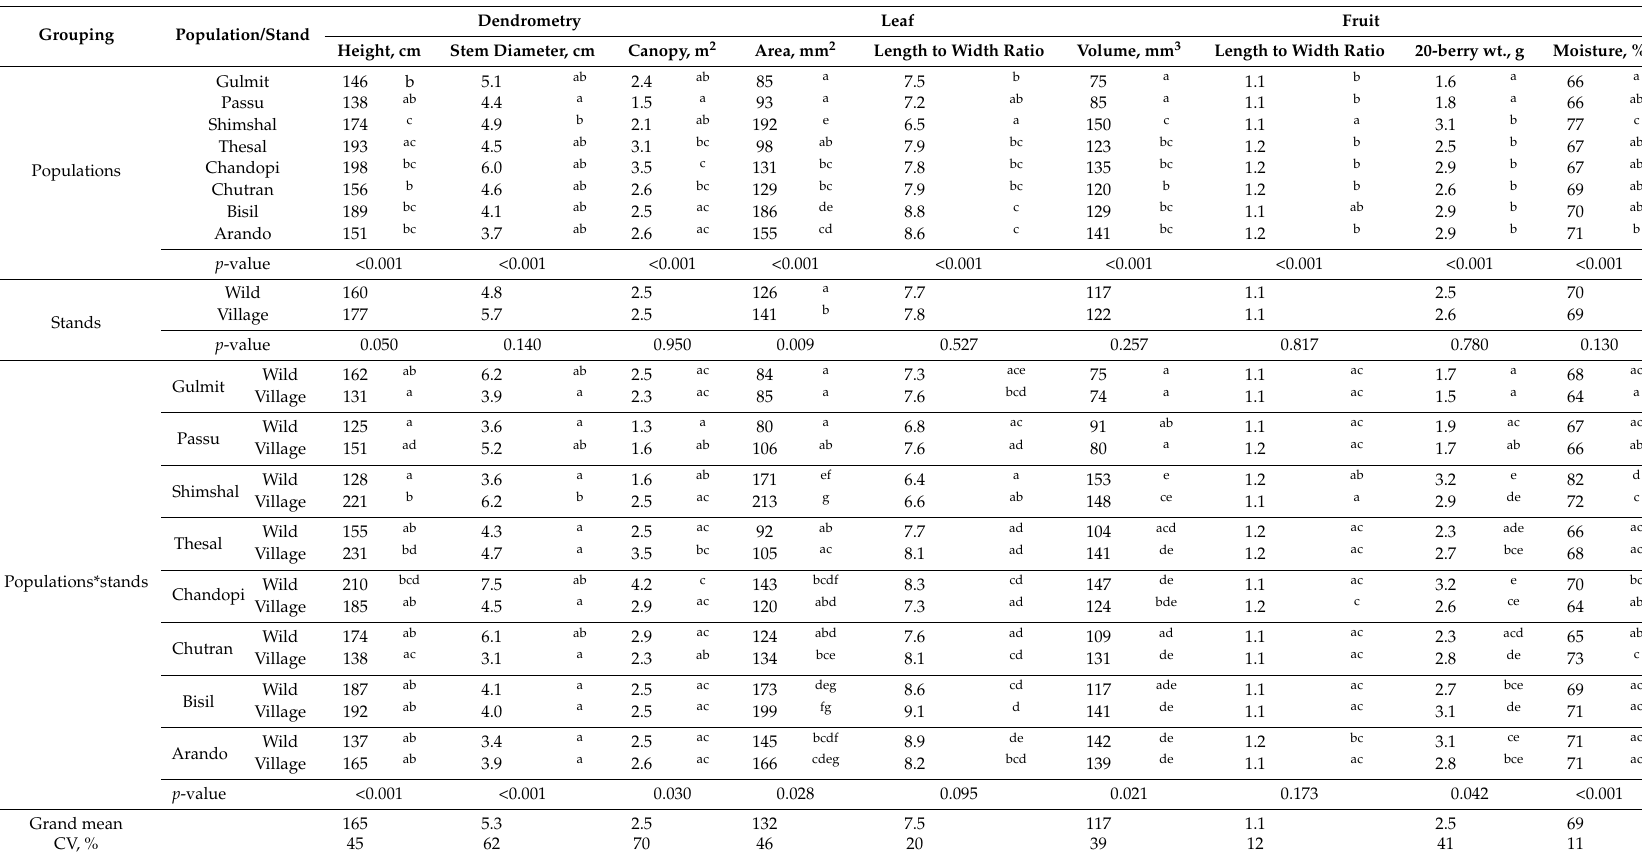
Table 2. Average morphological traits of sea buckthorn at the eight populations and their corresponding stands studied in the Gilgit and Baltistan regions, Pakistan. Grouping Population/Stand